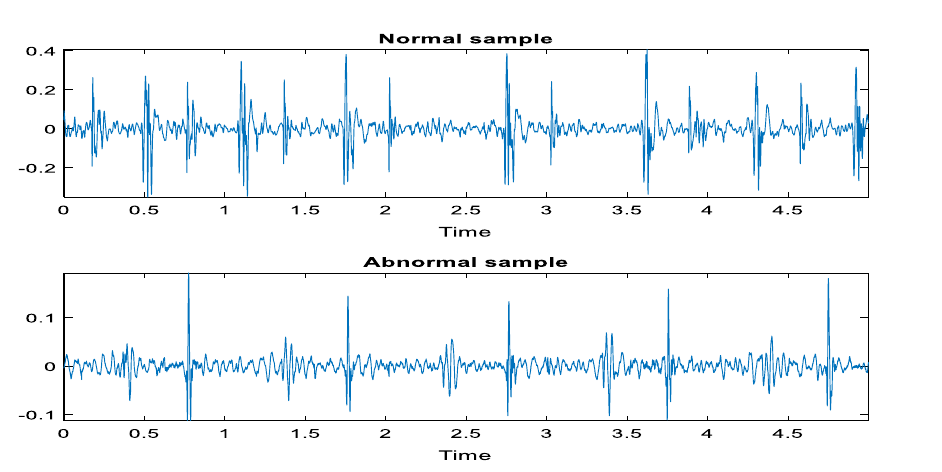
Figure 3. Sample PCG records from the second